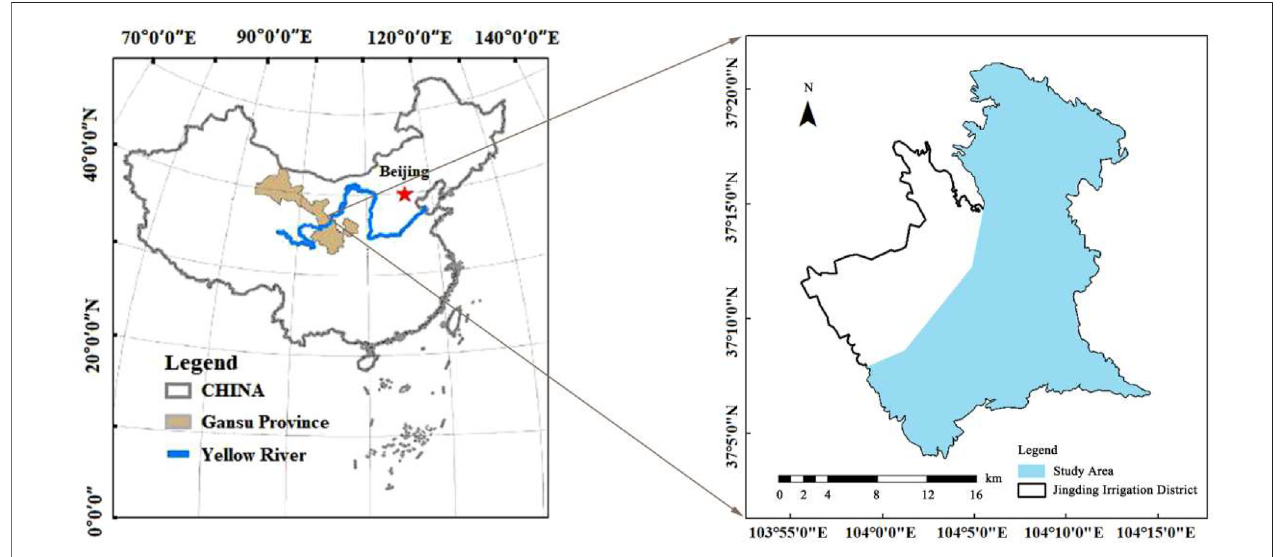
FIGURE 1 | Geographical location diagrams of the study